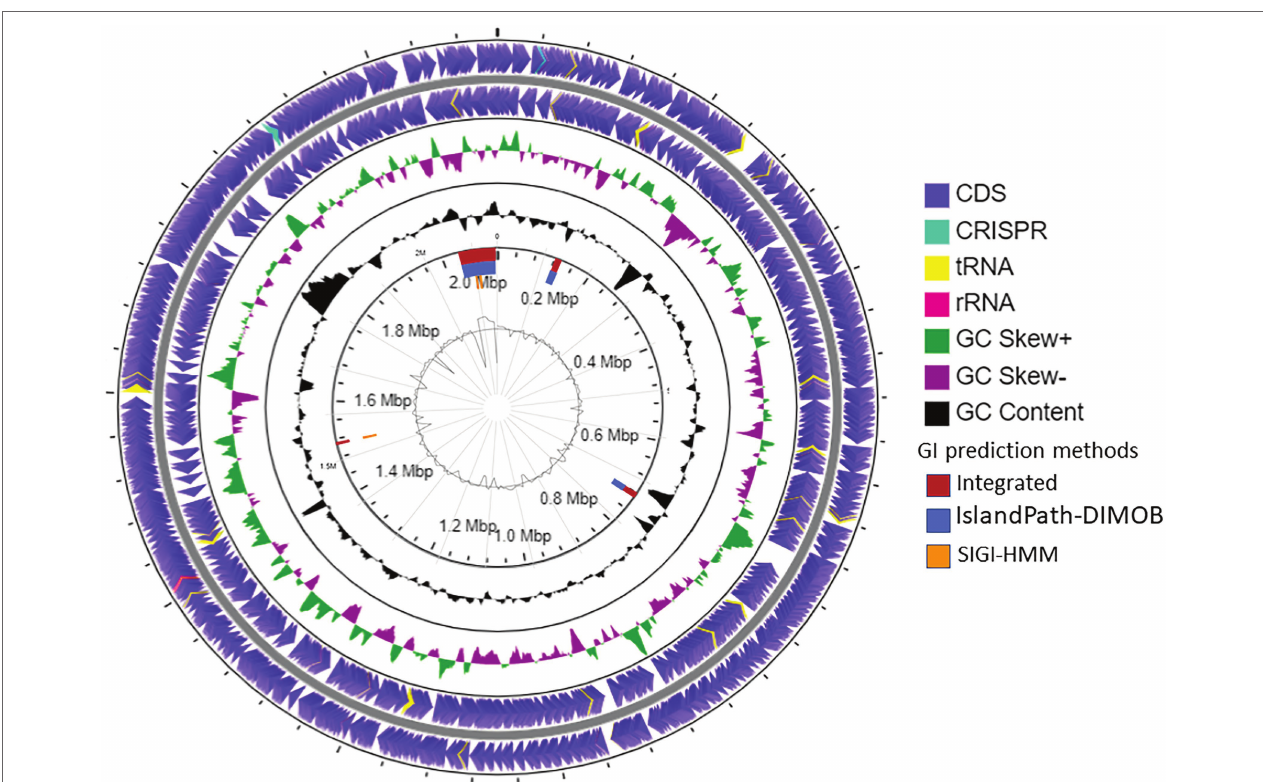
FIGURE 3 | Schematic representation of the genome of A. neptunius SE56 T . Labeling from the outside to the center is as follows: circle 1, genes on the forward strand; circle 2, genes on reverse strand [tRNAs yellow, ribosomal RNAs (rRNAs) lilac pink, and clustered regularly interspaced short palindromic repeats (CRISPR) cyan blue]; circle 3, G + C skew; circle 4, G + C content; circle 5, genomic islands shown as red, blue, and orange rectangles attributed, respectively, to integrated, IslandPath-DIMOB and SIGI-HMM prediction genomic islands methods; and circle 6, IslandViewer4 automatic calculation of the G + C content.